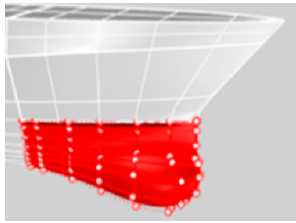
Figure 1. Ship model (side view). The red lines indicate the sonar dome.